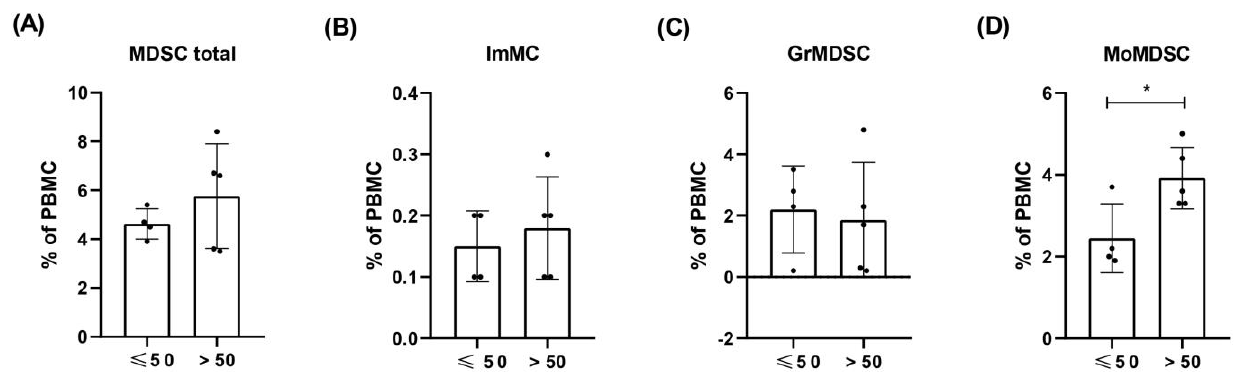
Figure 3. Levels of circula ting ImMC, GrMDSC, MoMDSC and MDSC total cells in HC depending on the age. Healthy volunteers were divided into two groups based on their age: ≤50 (the mean age 42 ± 7.75 years) and >50 (the mean age 63 ± 6.16 years) and compared cell levels between them. MDSCs levels were evaluated as % of PBMC. Levels of ( A ) total MDSC, ( B ) immature monocytic cells (ImMC), ( C ) granulocytic MDSC (GrMDSC) and ( D ) monocytic MDSC (MoMDSC). Data are shown as a mean ± SD, * p ≤ 0.05.